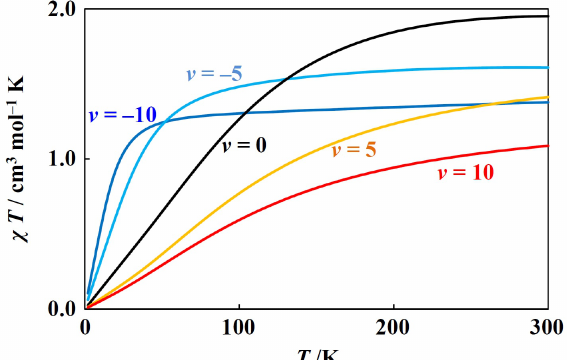
Figure 2. Theoretical χ T versus T plot for tetrahedral nickel(II) complexes ( λ = − 100 cm − 1 , κ = 0.9, v = − 10, − 5, 0, 5, and 10).